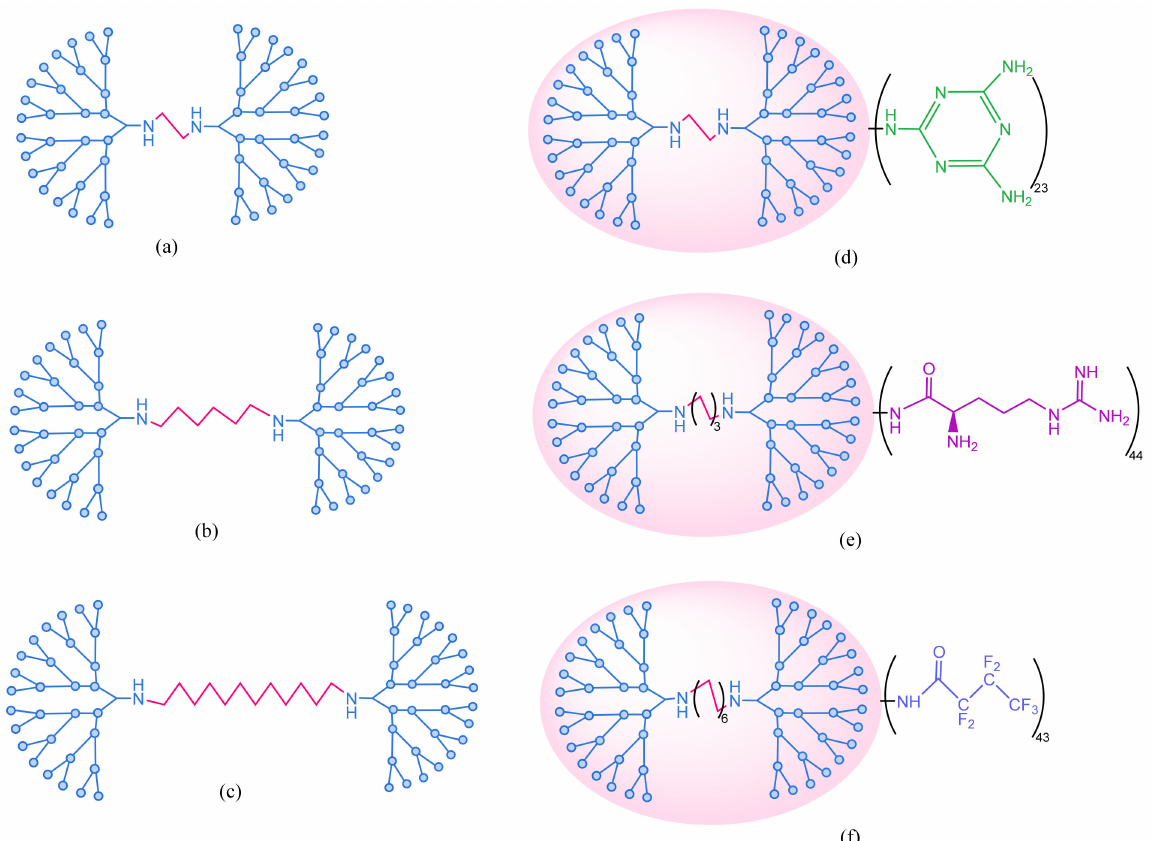
Figure 10. PAMAM dendrimers with a central structure consisting of diaminoethane ( a ), diaminohexane ( b ) and diaminodo- decane ( c ) radicals; PAMAM dendrimers obtained by modulating the surface structures of diaminoethane derivatives with triazine ( d ), diaminohexane derivatives with arginine ( e ) and diaminododecane derivatives with fluoroalkyls ( f ). Adapted from [223], published by Acta Biomaterialia,